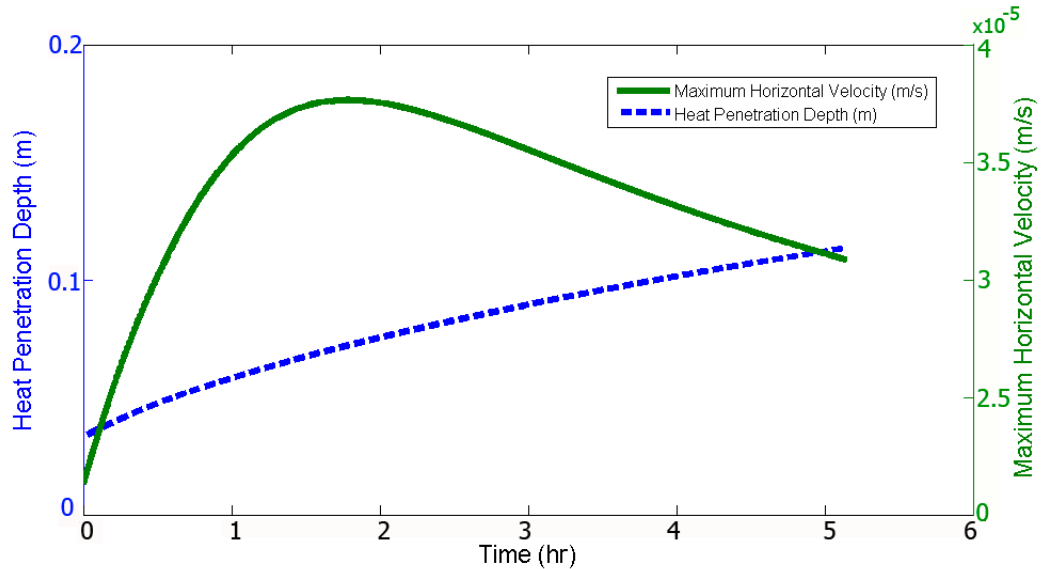
. γ 0.15 = 0.15. . H  0.15 H H